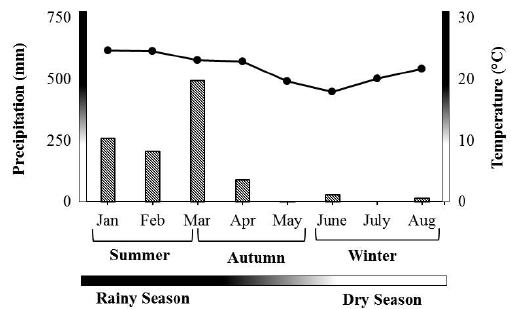
Figure 2. Monthly variation of air temperature (line - °C) and precipitation (bars - mm) during analysis, indicating the rainy and dry